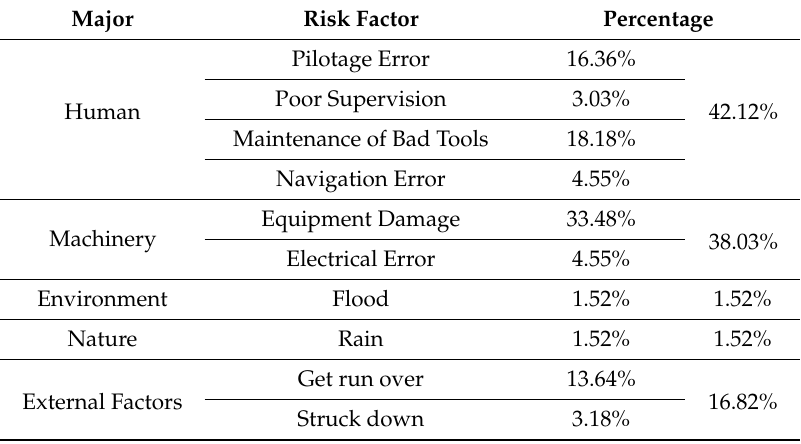
Table 7. Common causes of loading and unloading